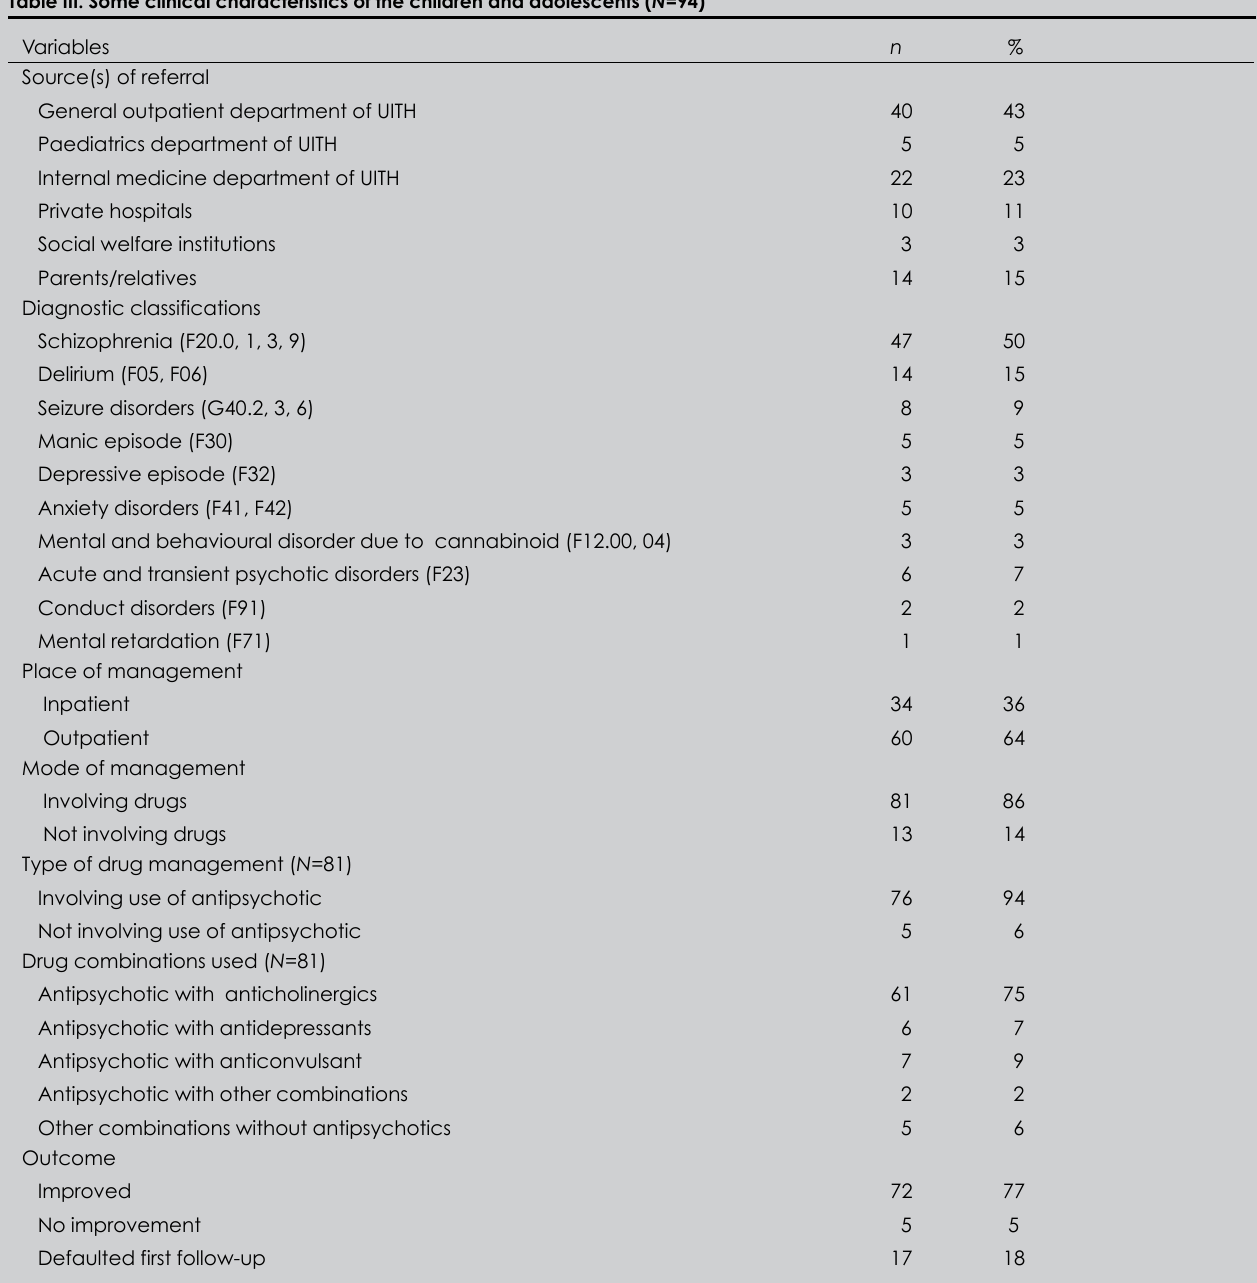
Table III. Some clinical characteristics of the children and adolescents ( N =94) Variables